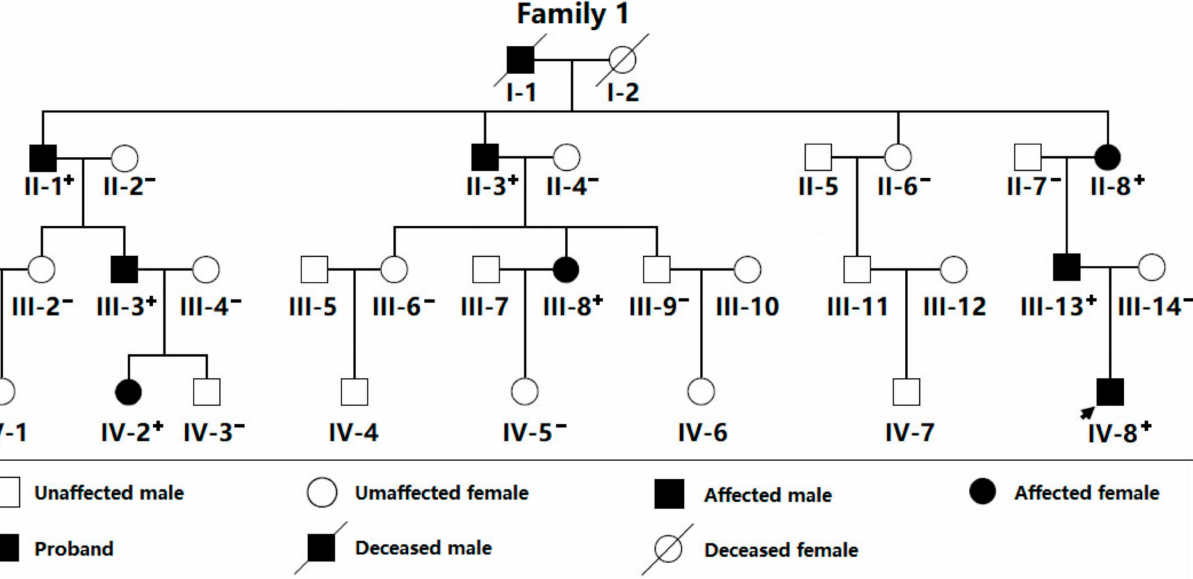
Figure 1. Pedigree affected by congenital cardiovascular abnormalities. A family member is identified by generation and number. “+” denotes a carrier of the identified SOX18 variation in a heterogeneous status; “ − ” represents a